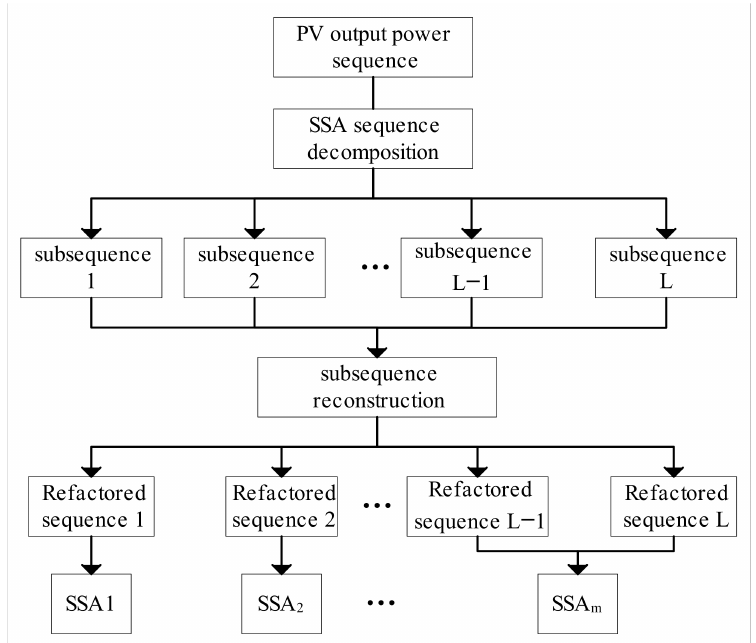
Figure 2. Flowchart of the SSA